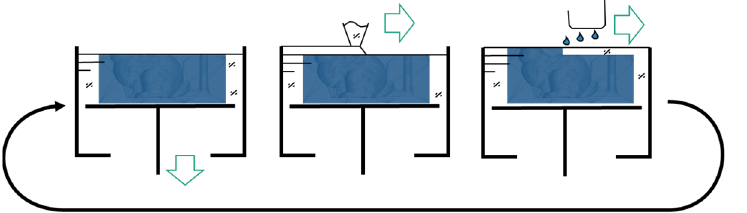
Figure 3. Schematic illustration of the steps characterizing the Binder Jetting process: First—lower platform, Second—recoat layer, Third—jet binder.